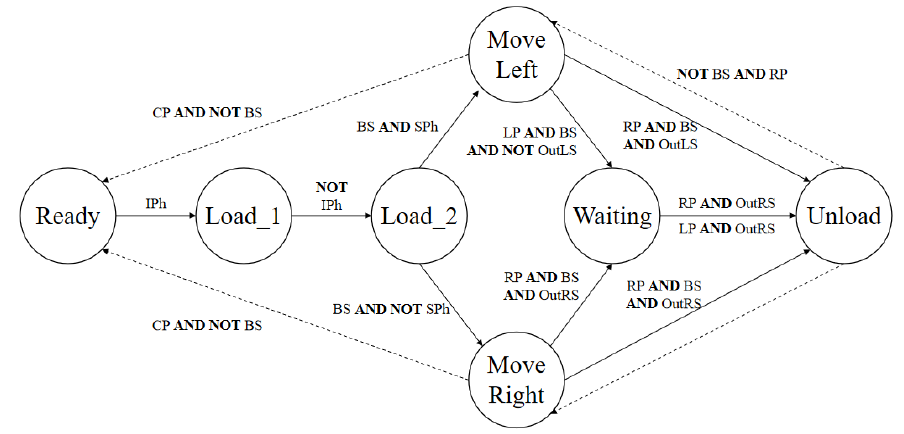
Figure 7. A state machine of the product